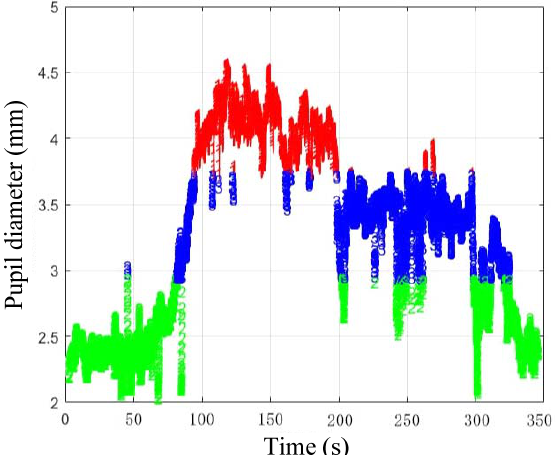
Figure 3. Cluster distribution diagram of driver pupil diameter.